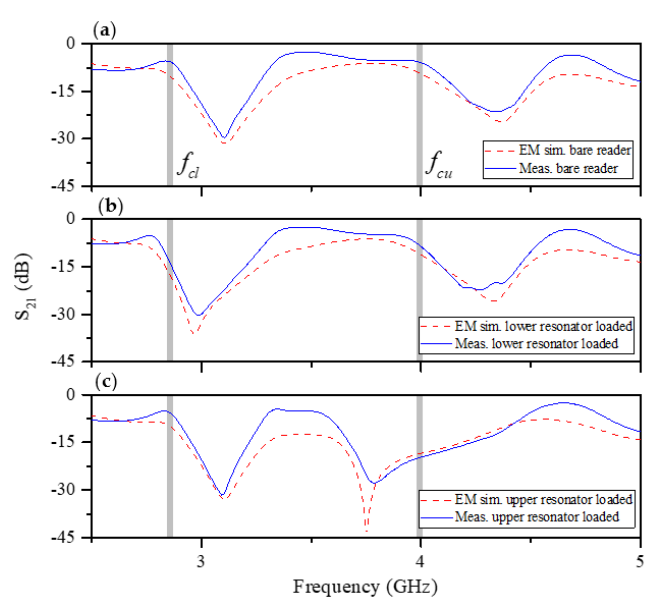
Figure 5. Electromagnetic simulation (including losses) and measured frequency responses of the ( a ) bare reader, ( b ) reader with the longer slot loaded with the RS MT-Copper on top of it, and ( c ) reader with the shorter slot loaded with RS MT-Copper on top of it. The simulation has been inferred by means of the Keysight ADS software